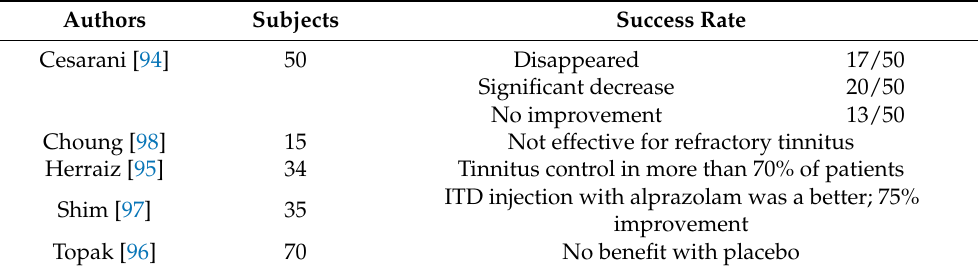
Table 13. Summary of studies that used intratympanic steroid injection to treat